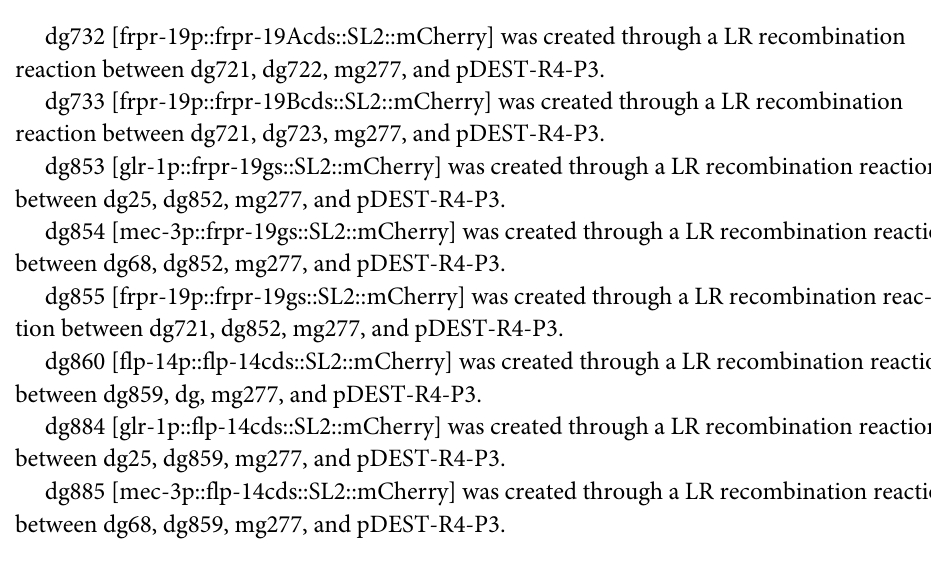
S3 Fig. Reversal rate scored during repeated stimulation protocols without